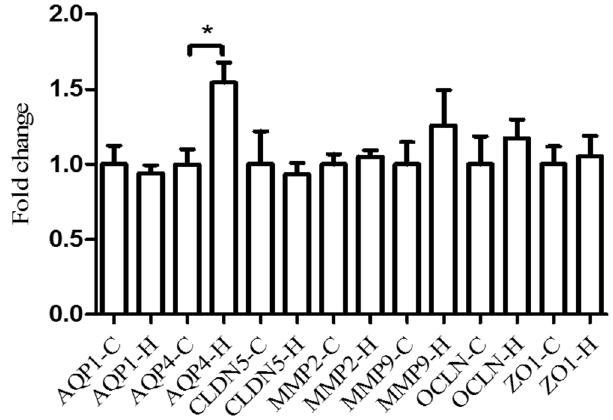
Figure 7. Quantification of immunostaining data. Ratio for fold change of AQP4 was significantly higher in the heat stroke group as compared to the control group. Significantly lower RIN values were detected in heat stroke group as compared to the control group ( * p <